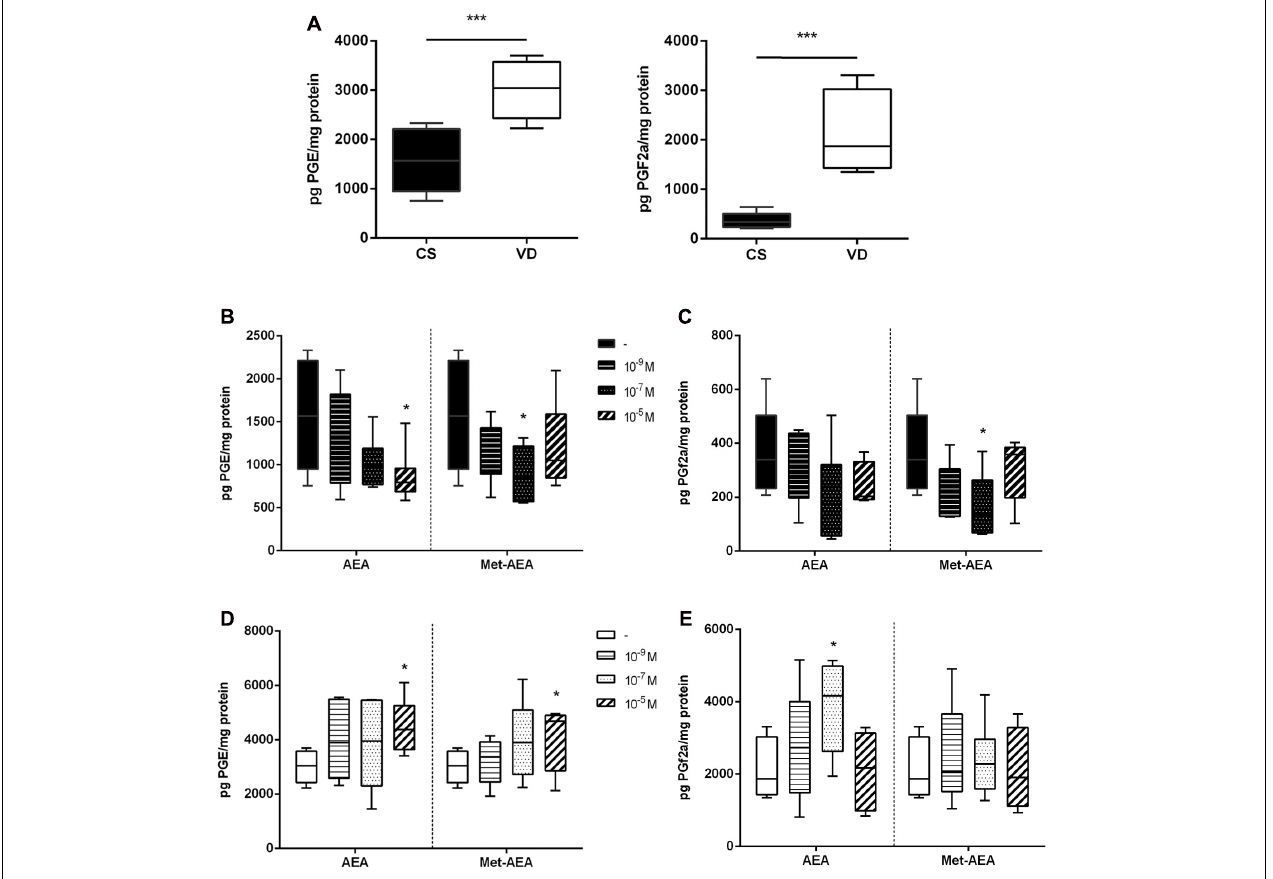
FIGURE 1 | Analysis of prostaglandins concentration in term placenta. (A) Basal prostaglandin E (left panel) and F2a (right panel) production in cesarean section (CS) and vaginal delivery (VD) placentas (*** P < 0.001, n = 10). (B) Prostaglandin E and (C) prostaglandin F2a production measured after culturing CS placentas with different concentrations of AEA or Met-AEA (* P < 0.05 vs. control, n = 10). (D) Prostaglandin E and (E) prostaglandin F2a production measured after culturing VD placentas with different concentrations of AEA or Met-AEA (* P < 0.05 vs. control, n =